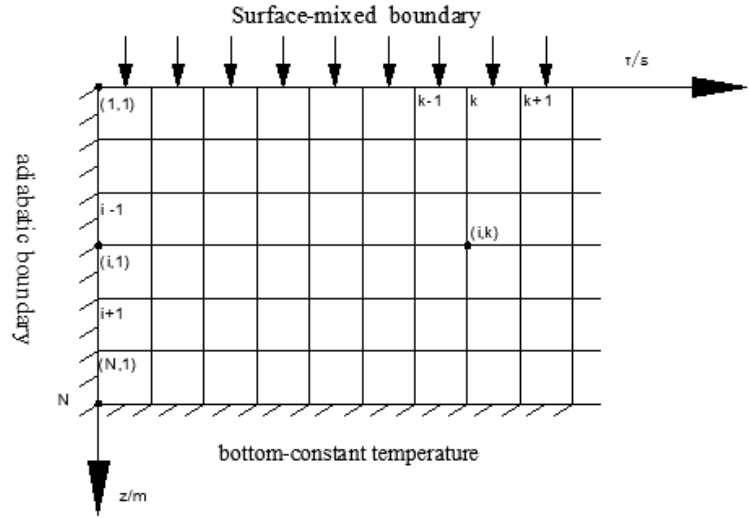
Figure 2. Model for predicting the temperature in an asphalt pavement.